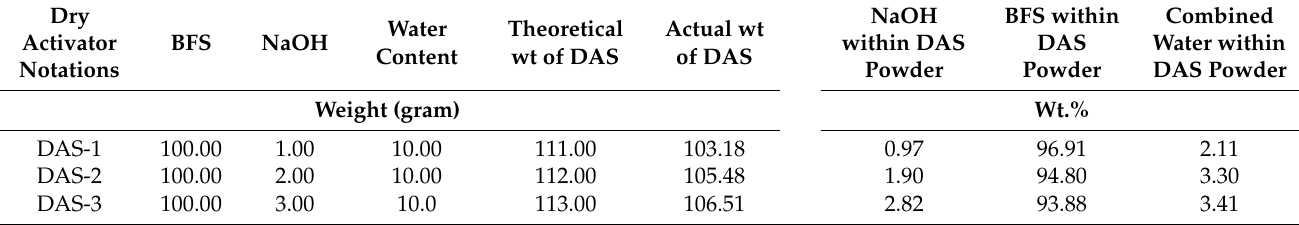
Table 2. Compositions of the prepared dry activator–based slag (DAS).